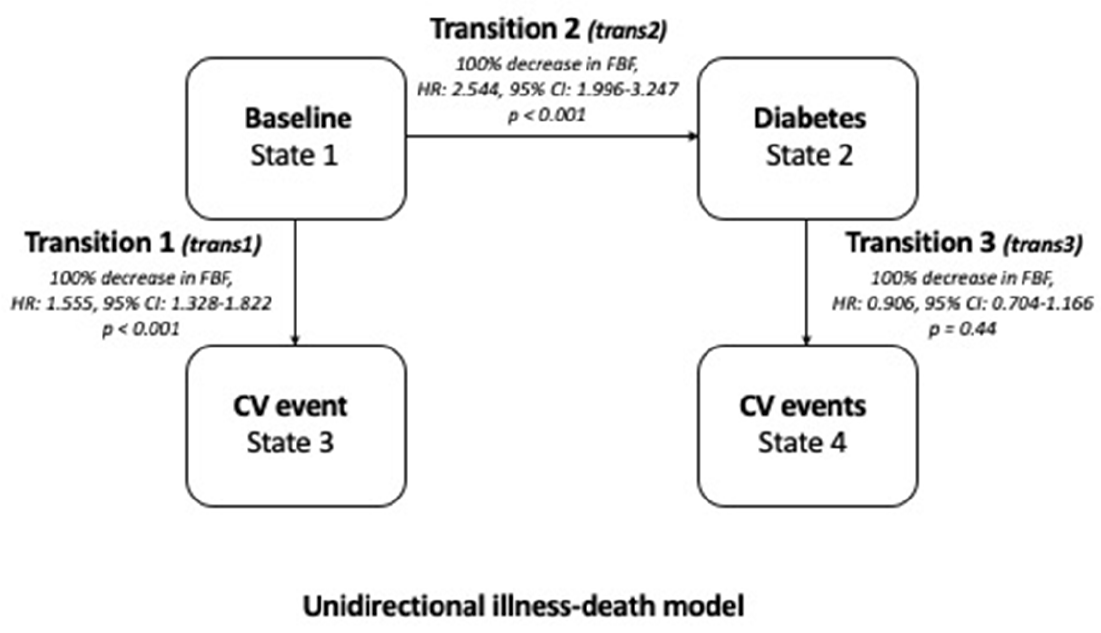
Figure 2. The unidirectional illness-death model. Data are hazard ratios, 95% Cis, and p -values. The effect of a fixed decrease ( − 100%) of FBF was assessed from each transition (see Statistical analysis for more details) according to the endpoint indicated by the arrows.